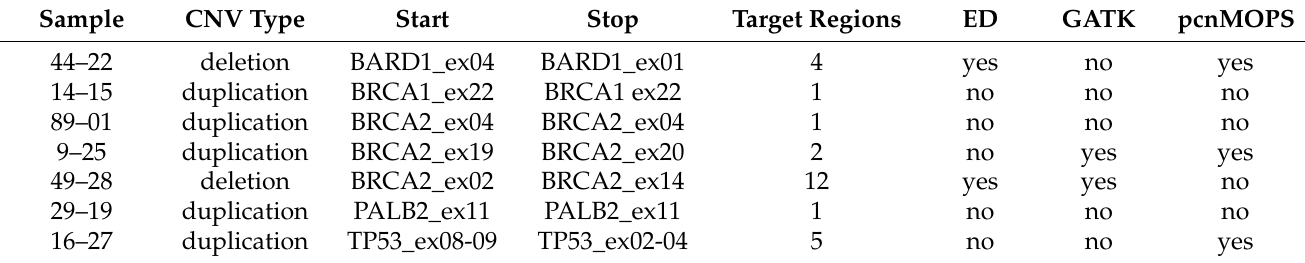
Table 2. True positive CNVs predicted by Sophia Genetics DDM, but missed by either ExomeDepth (ED), GATK gCNV (GATK), or panelcn.MOPS (pcnMOPS). yes = CNV was predicted by the respective tool. no = CNV was missed by the respective